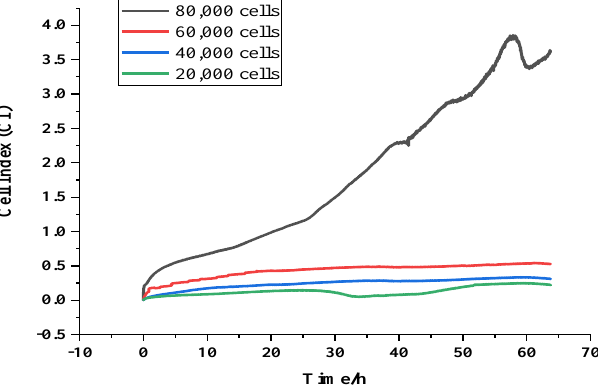
Figure 2. Comparison of the cell indices at different cell densities.